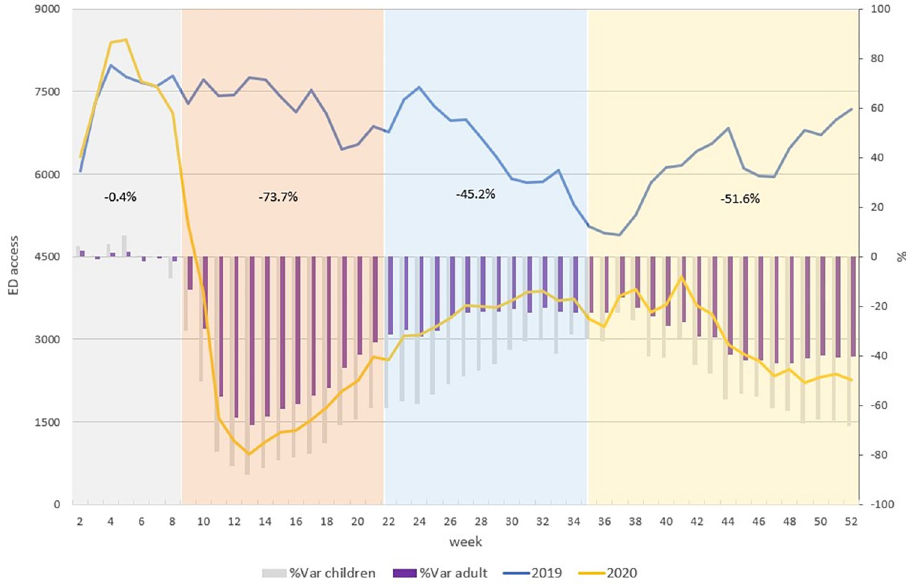
Fig 1. Weekly trend of pediatric access to ED for all causes (2019, 2020). The blue line refers to pediatric ED accesses in 2019, the yellow line to pediatric ED accesses in 2020. The grey bars indicate the percent variation of pediatric ED accesses in 2020 and 2019 and purple bars indicate the percent variation of adult ED accesses in 2020 and 2019. Different colours of the time represent the four phases of the pandemic in 2020: Grey = pre-lockdown, orange = lockdown, light blue = post lockdown and yellow = the second wave.The trend of pediatric accesses by week showed a higher number of visits in ED during the end of January and the first part of February 2020 compared to 2019 and then a huge decreased starting from the end of February 2020 and across the beginning of the lockdown period. From the end of March 2020 to September, pediatric visits to ED start to increase but, in spite of that, are lower compared to 2019. This trend decreases again during the 2 nd wave period. The percentage variation of pediatric access in 2020, compared to 2019, had the same trend of what was observed in adult population (%Var adult) in the same period, but the reduction is